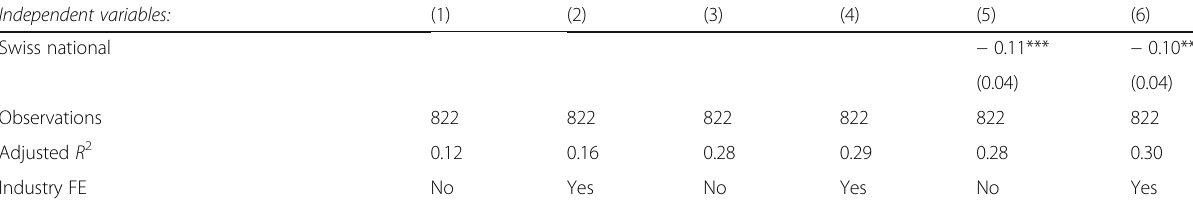
Table 2 Determinants of the use of the short-term work (Continued) Independent